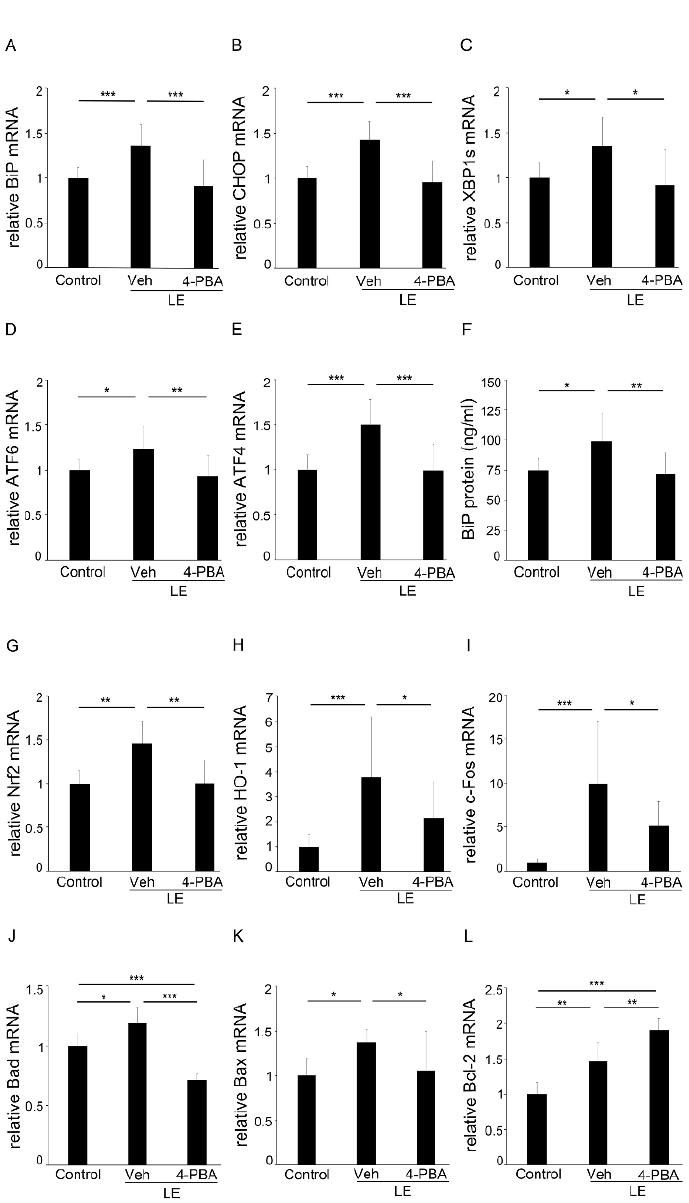
Figure 4. 4-PBA reduced ER and oxidative stress, and apoptotic markers. ( A – E ) mRNA expression of ER stress markers using RT-PCR 3 h after LE. mRNAs of ( A ) the immunoglobulin heavy chain binding protein (BiP), ( B ) CHOP, ( C ) XBP1s, ( D ) ATF6, and ( E ) ATF4 were upregulated in the LE- with-vehicle-treatment-group, but the mRNA levels remained close to those of the control in the LE-treated-with-4-PBA group. ( F ) BiP protein levels measured using enzyme-linked immunosorbent assay 3 h after LE showed similar results to those of the BiP mRNA levels. mRNAs of oxidative stress markers, ( G ) Nrf2 and ( H ) HO-1 measured with reverse transcription-polymerase chain reaction (RT-PCR )were also upregulated 3 h after LE; however, the levels were reduced by 4-PBA ( I ) c-Fos (3 h), which contributes to photoreceptor apoptosis after LE, and mitochondrial pro-apoptotic factors Bad) (3 h) ( J ) and Bax (6 h) ( K ) were also upregulated after LE; however, 4-PBA treatment suppressed these levels. Mitochondrial anti-apoptotic factor Bcl-2 ( L ) was upregulated immediately (0 h) after LE and was further increased in the 4-PBA-treated group. ER, endoplasmic reticulum; LE, light exposure; Veh, vehicle. Data are presented as mean ± standard deviation. ( A–F ) n = 9–12; ( G ) n = 6 in each group; ( H ) Control: n = 18, LE with vehicle: n = 15 and LE with 4-PBA: n = 14; ( J, L ) Control: n = 6, LE with vehicle: n = 5 and LE with 4-PBA: n = 6; ( K ) n = 11/group. * p < 0.05, ** p < 0.01, *** p < 0.001. ANOVA with Tukey post-hoc